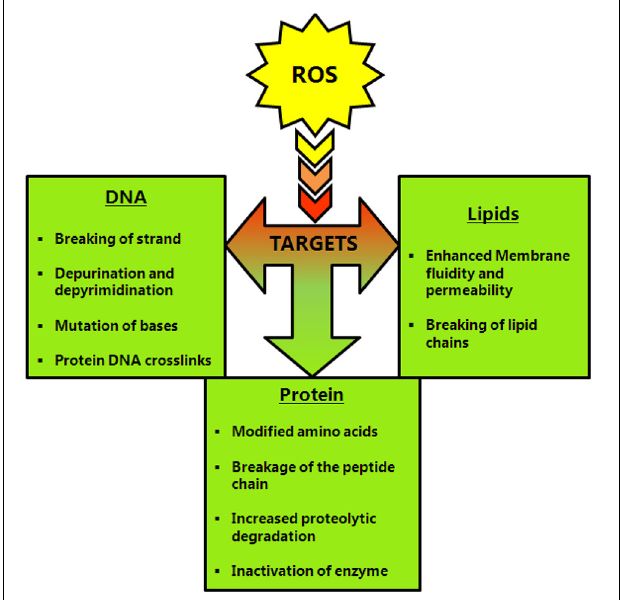
FIGURE 3 | Various targets of